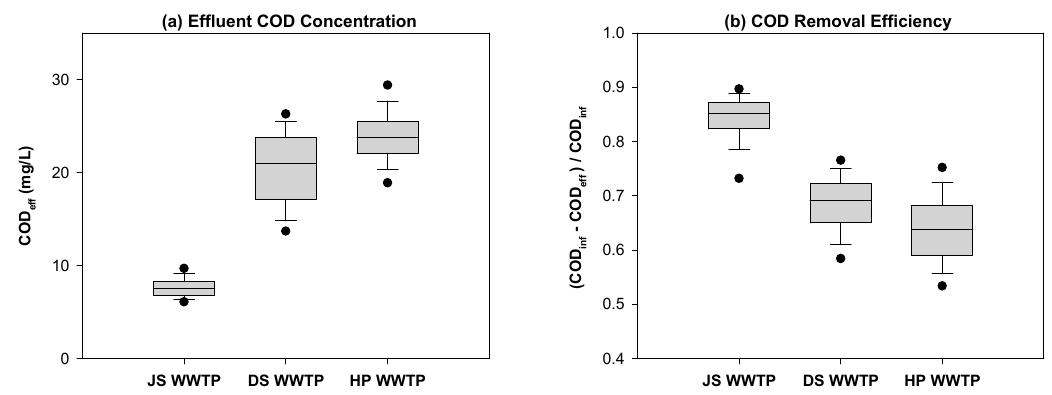
Figure 6. Box plots of ( a ) the effluent COD concentrations and ( b ) the normalized COD removal efficiency of the biological treatment processes of the JS, DS, and HP WWTPs. The WWTPs’ monitoring data from recent years (2013–2015) were used for the statistical analysis.